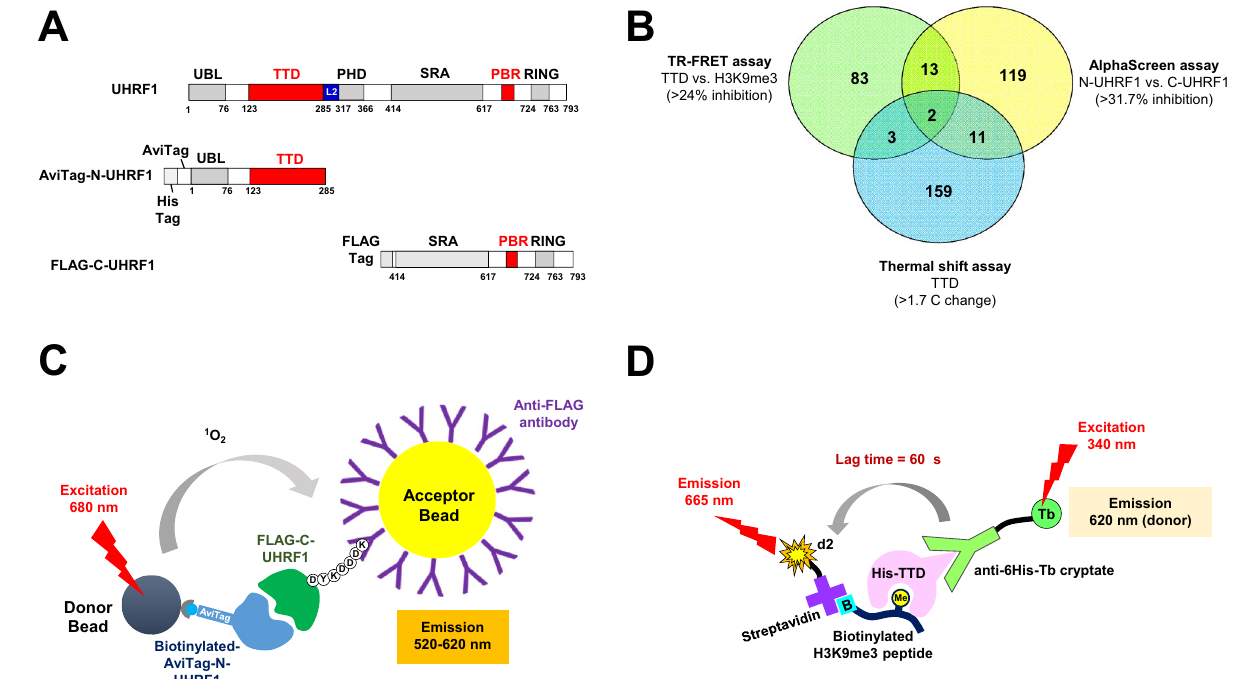
Figure 1. Three parallel assays identify TTD-targeting fragments by screening against the ~ 2300-compound Life Chemical fragment library ( A ) The domain structure of UHRF1 and the two truncated constructs, Avitag- N-UHRF1 and FLAG-C-UHRF1 for AlphaScreen. ( B ) The Venn diagram represents the level of hits overlaping between the three parallel screening assays. ( C ) Experimental setting for the AlphaScreen-based screening assay for fragments targeting N-UHRF1-C-UHRF1 interaction. ( D ) Experimental setting for the TR-FRET screening assay for identifying fragments that inhibit His-TTD interaction with H3K9me3